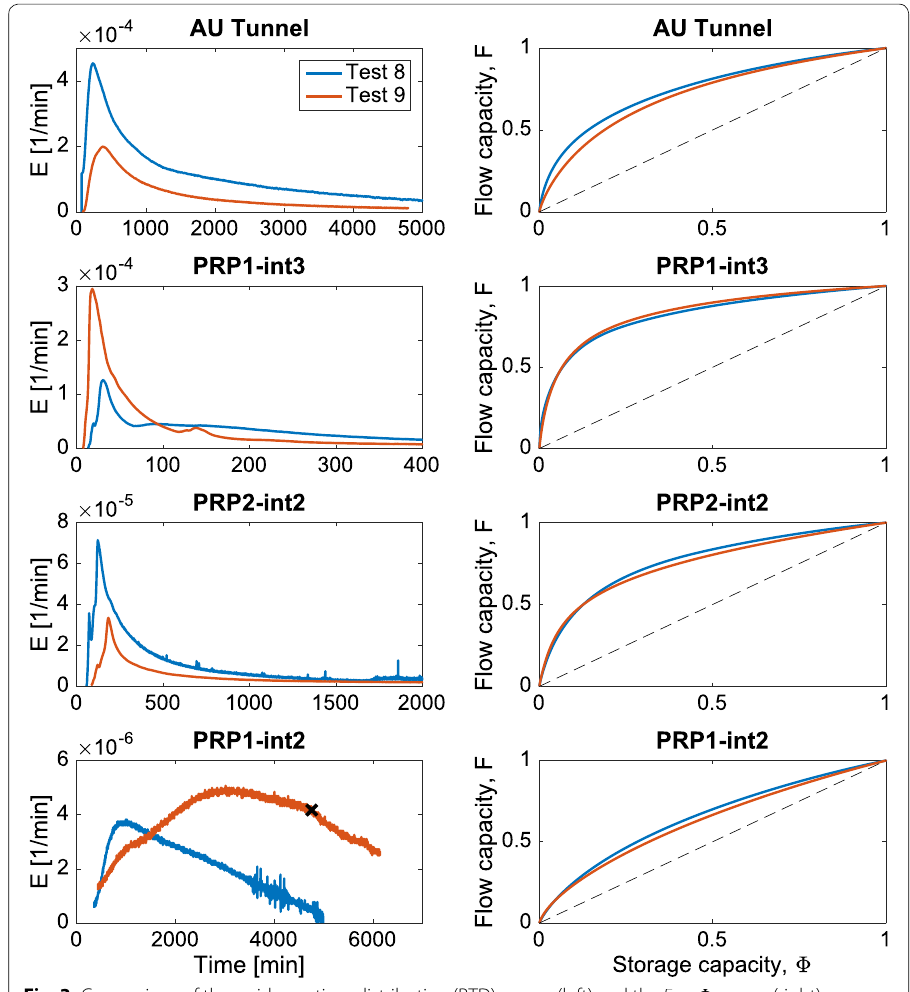
Fig. 3 Comparison of the residence time distribution (RTD) curves (left) and the F − (cid:31) curves (right). The RTD and the F − (cid:31) curves are from before (Test 8) and during (Test 9) hot water injection at the four monitoring locations, namely the AU Tunnel outflow point, PRP1‑int3, PRP2‑int2, and PRP1‑int2. The x‑symbol on the Test 9 RTD curve, obtained from PRP1‑int2, marks the start of a 2‑day breakdown of the water injection system (Fig. 2) and the dashed diagonal lines in the F − (cid:31) plots represent a homogeneous fracture system. Note the different scales of the axes for the RTD